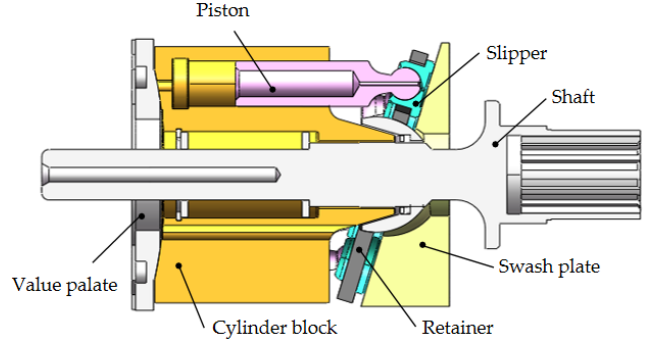
Figure 1. Configuration of a typical axial piston pump.